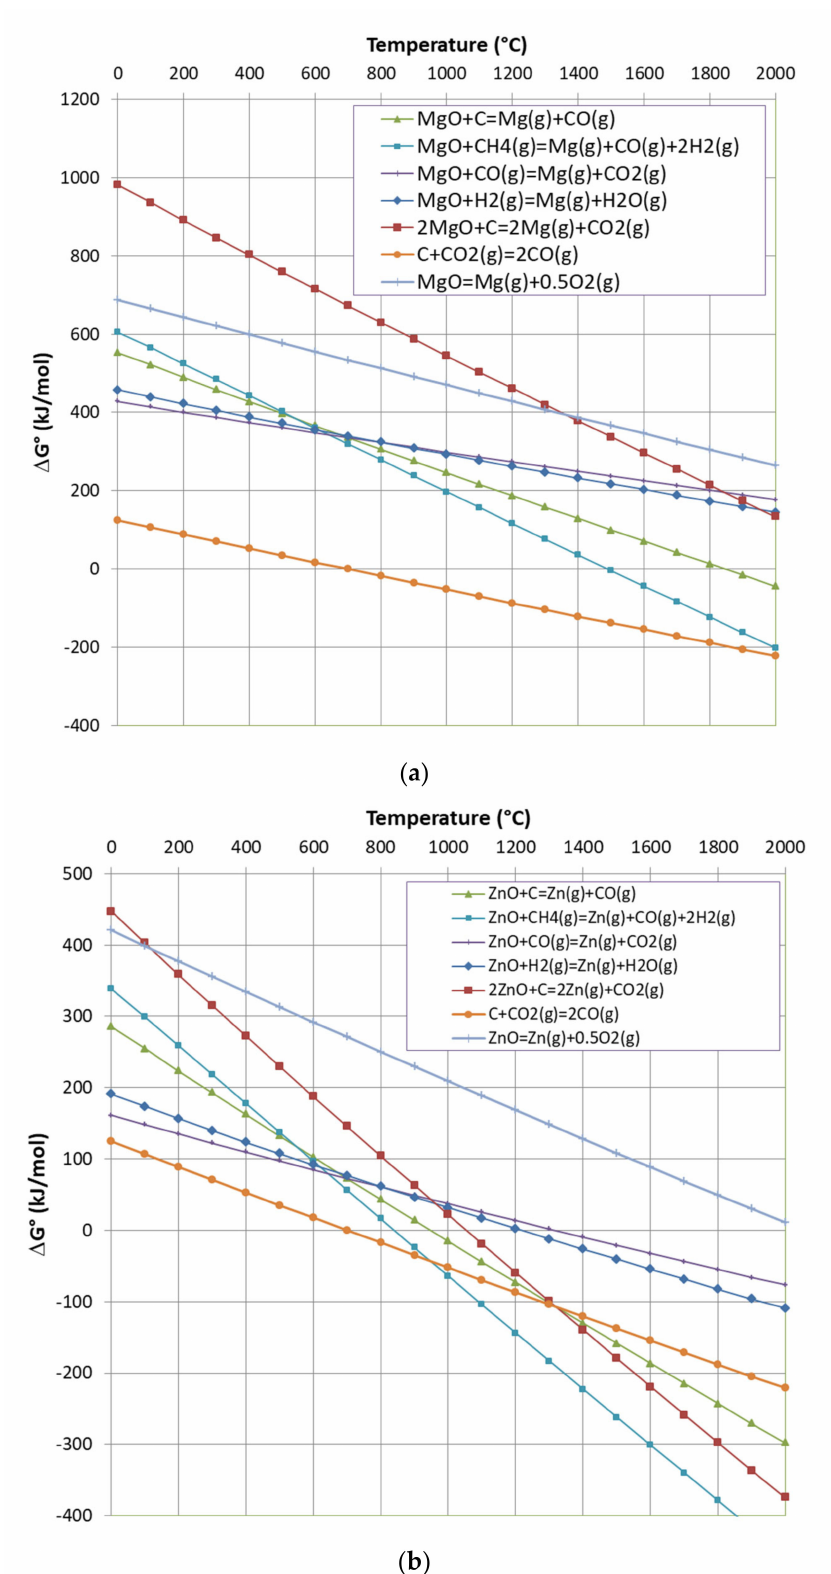
Figure 2. Evolution of Gibbs free enthalpy versus temperature of the main reduction reactions involving ( a ) MgO and ( b )